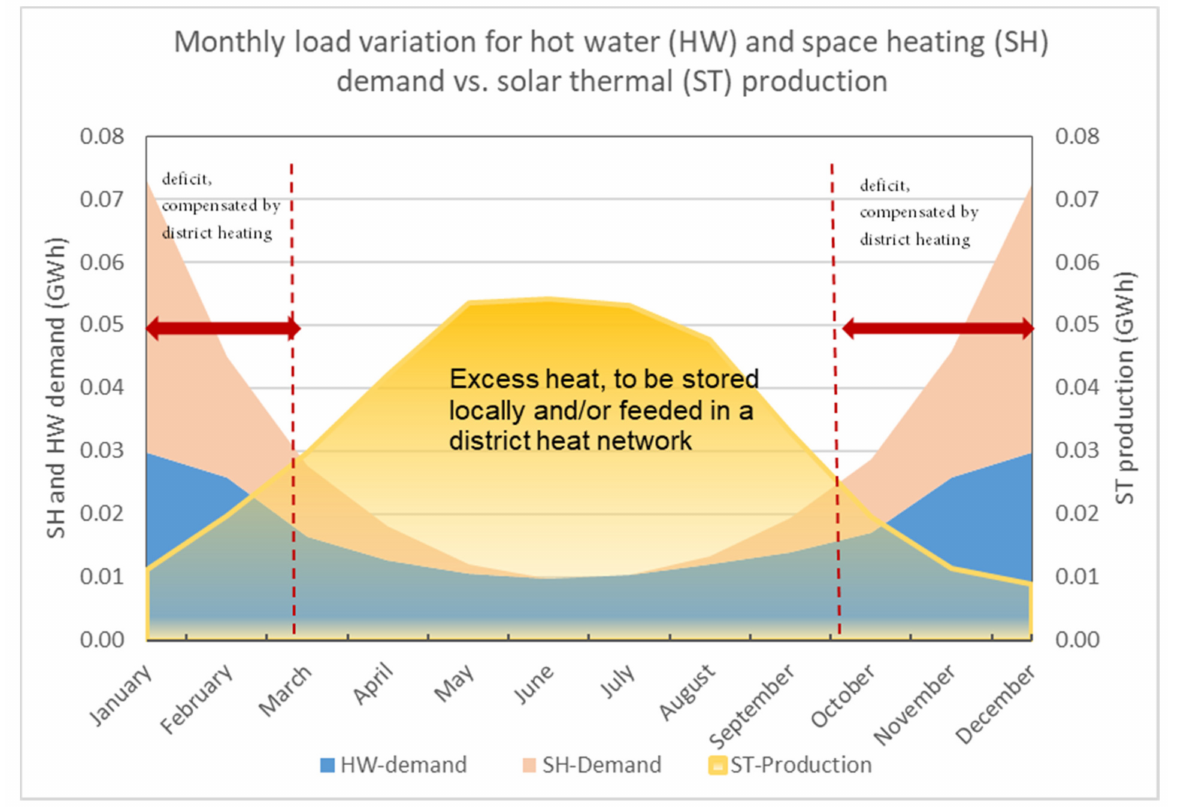
Figure 6. Monthly load curves for HW—hot water and SH—space heating demand and the supply curve of local ST— solar thermal: demonstrating the period of heat excess and deficit of the conceived PED in a detached housing district (source: